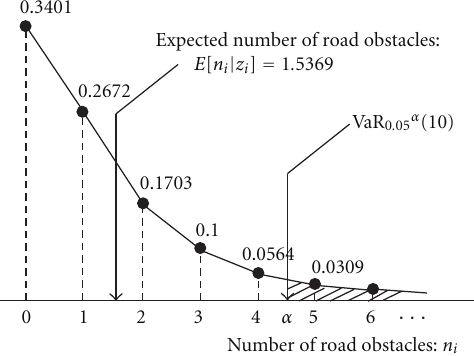
Figure 2: Distribution of road obstacle emergence.